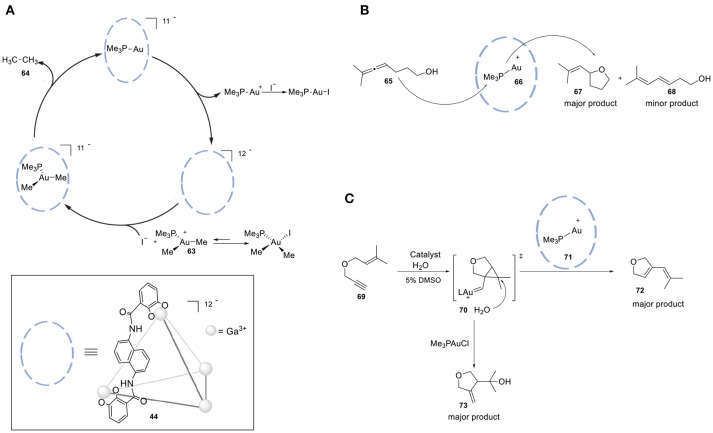
(A) Catalytic alkyl-alkyl cross-coupling by utilizing a highly anionic supramolecular catalyst. (B) Selective hydroalkoxylation of allene 52. (C) Catalysis of the intramolecular cyclo-isomerization reaction by the encapsulated gold complex compared to the free gold catalyst.